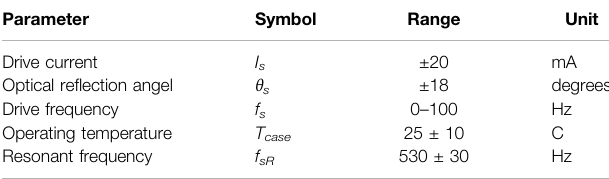
TABLE 1 | Electrical and optical characteristics of the MEMS mirror.